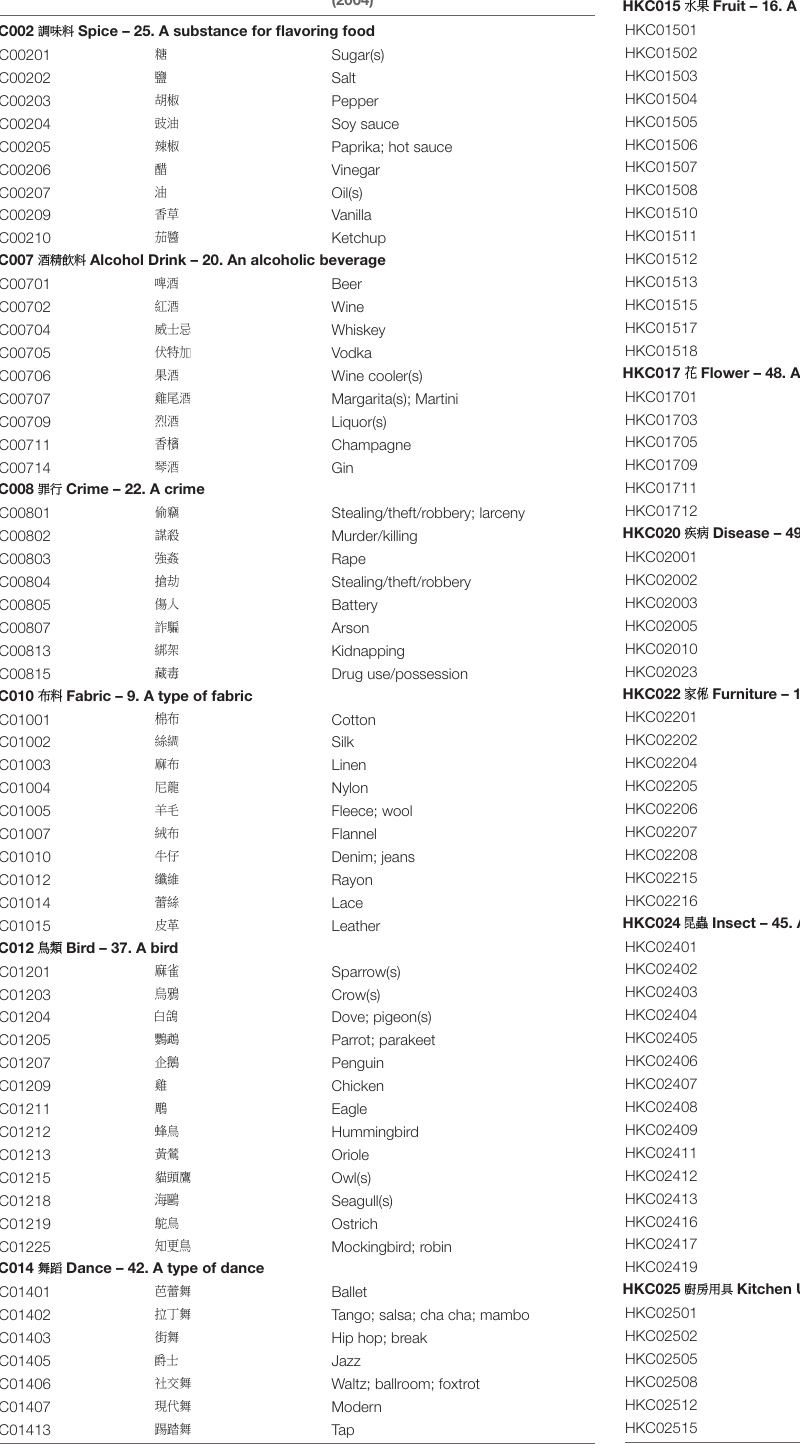
TABLE 6 | Comparison with the English norm of Van Overschelde et al. (2004), showing the overlapping exemplars in the mutually included categories. Word Code Exemplar in